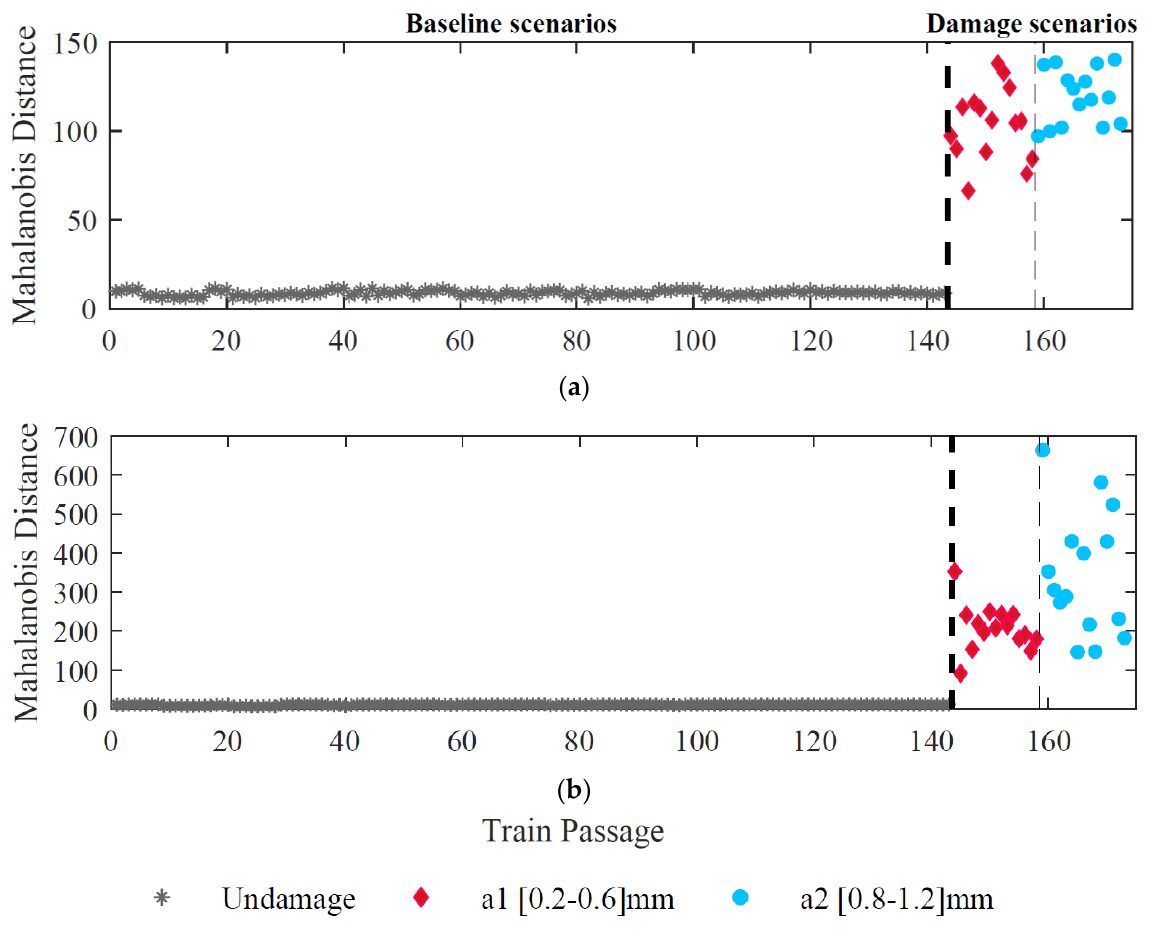
Figure 15. Features fusion for sensor 1, ( a ) ARX – PCA – based, ( b ) CWT – double – PCA – based.